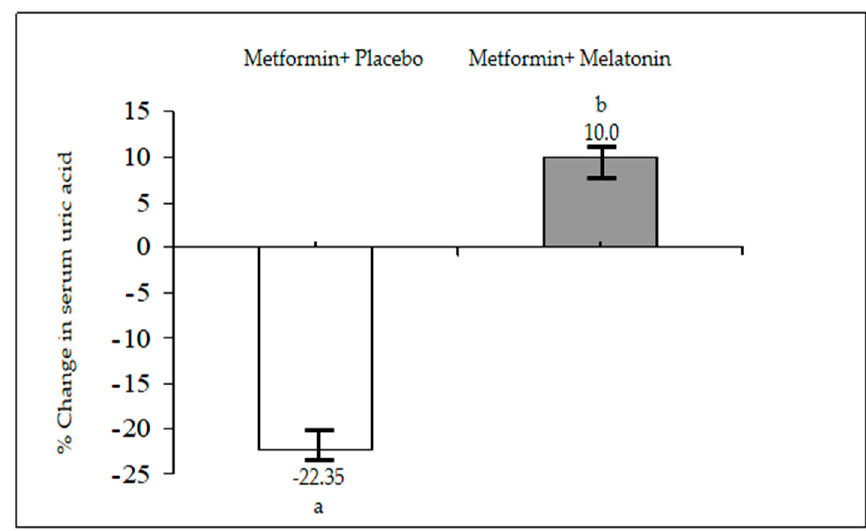
Figure 4. Comparison between the effects of metformin-placebo and metformin-melatonin on serum UA level in MEBS patients after 90 days of treatment; (a, b) significantly different ( p < 0.05). UA: uric acid.